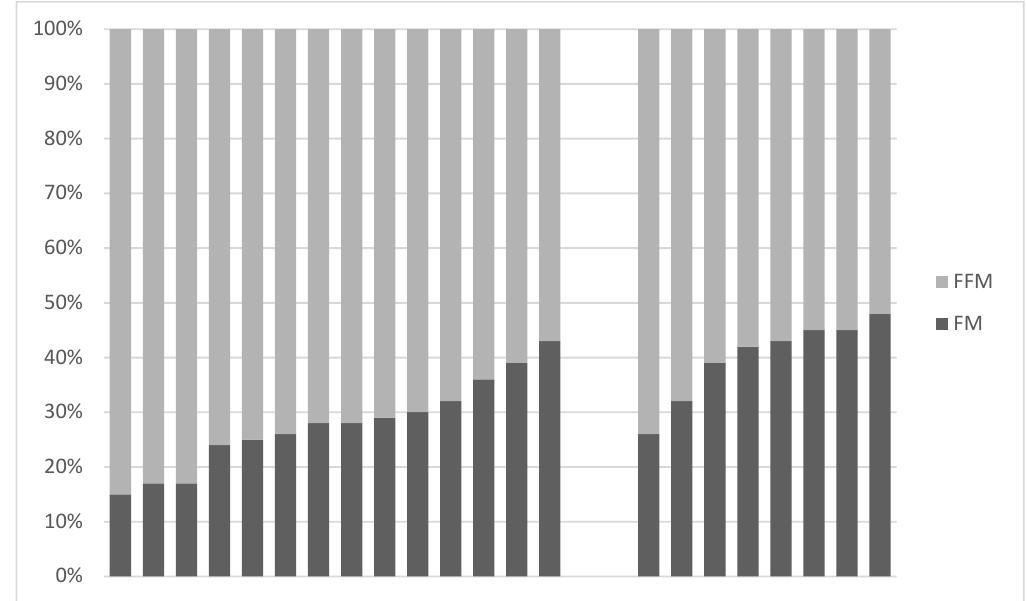
Figure 1. Relationship between percent fat mass (FM) and percent fat free mass (FFM) in 22 adults with PWS, left to right: 14 men on GH treatment, 8 women on GH treatment.